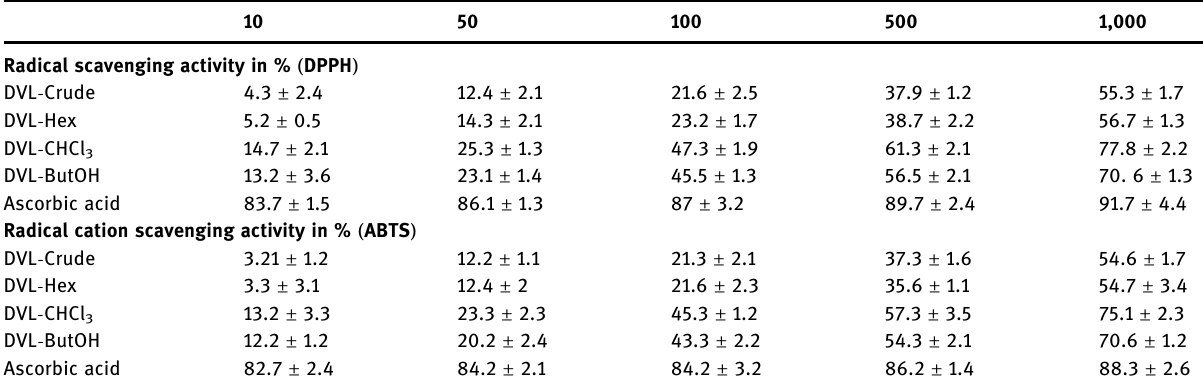
Table 1: The scavenging ability of DVL extract and fractions in DPPH and ABTS assays